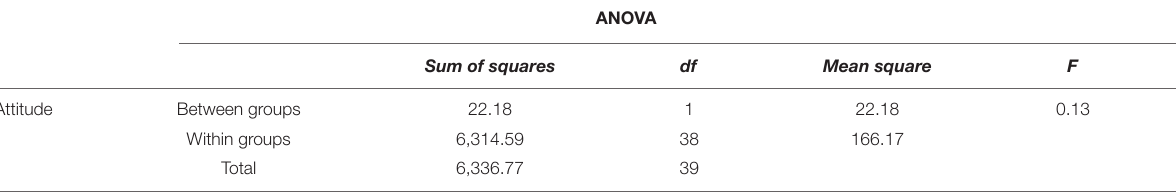
TABLE 7 | ANOVA test for the relation between attitudes and professional rank.